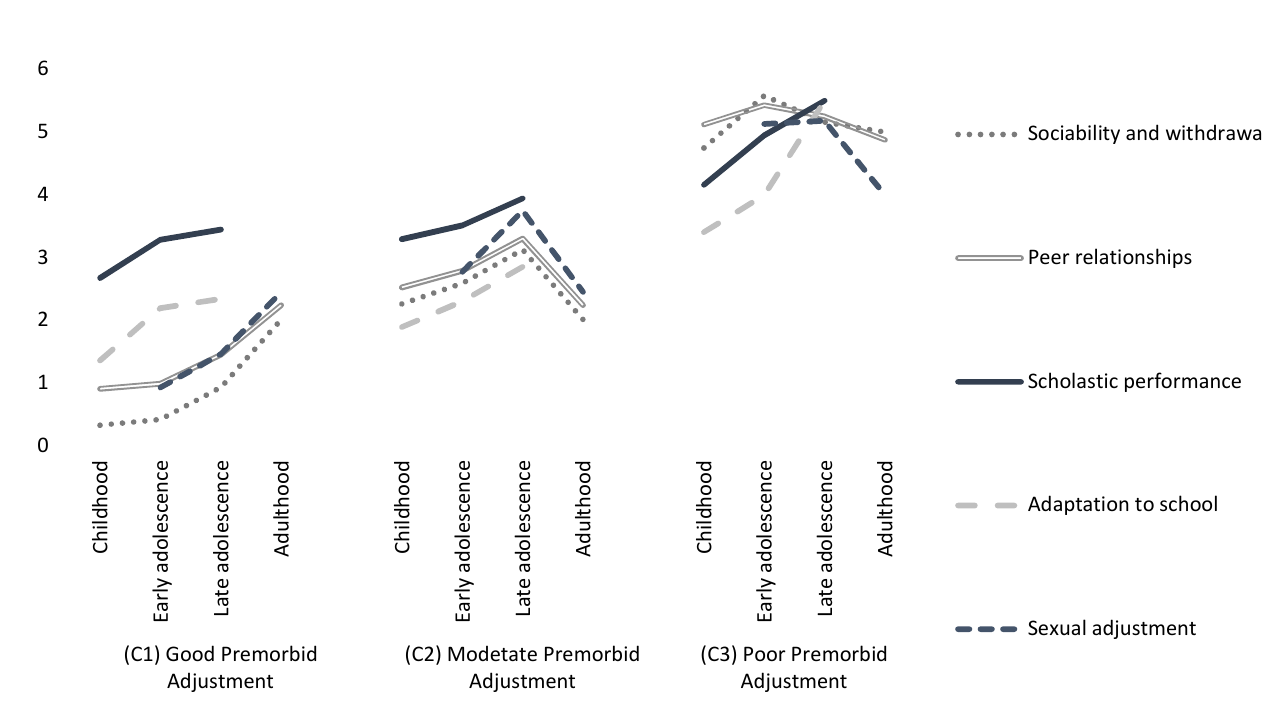
Figure 1. Means of latent profiles for pre-morbid adjustment scores in the sample. Table 4 presents the distribution of means for the total sample and for the classifica- tion of latent profiles in each subdimension of the PAS and the study covariates. Statisti- cally significant differences were observed in all dimensions of the PAS among the premorbid adjustment latent profiles. Statistically significant differences were also ob- served between latent profiles on all clinical variables. No significant differences were ob- served between the latent profiles of premorbid adjustment with respect to sex or ethnic- ity. Table 4. Descriptive statistics of clinical variables.